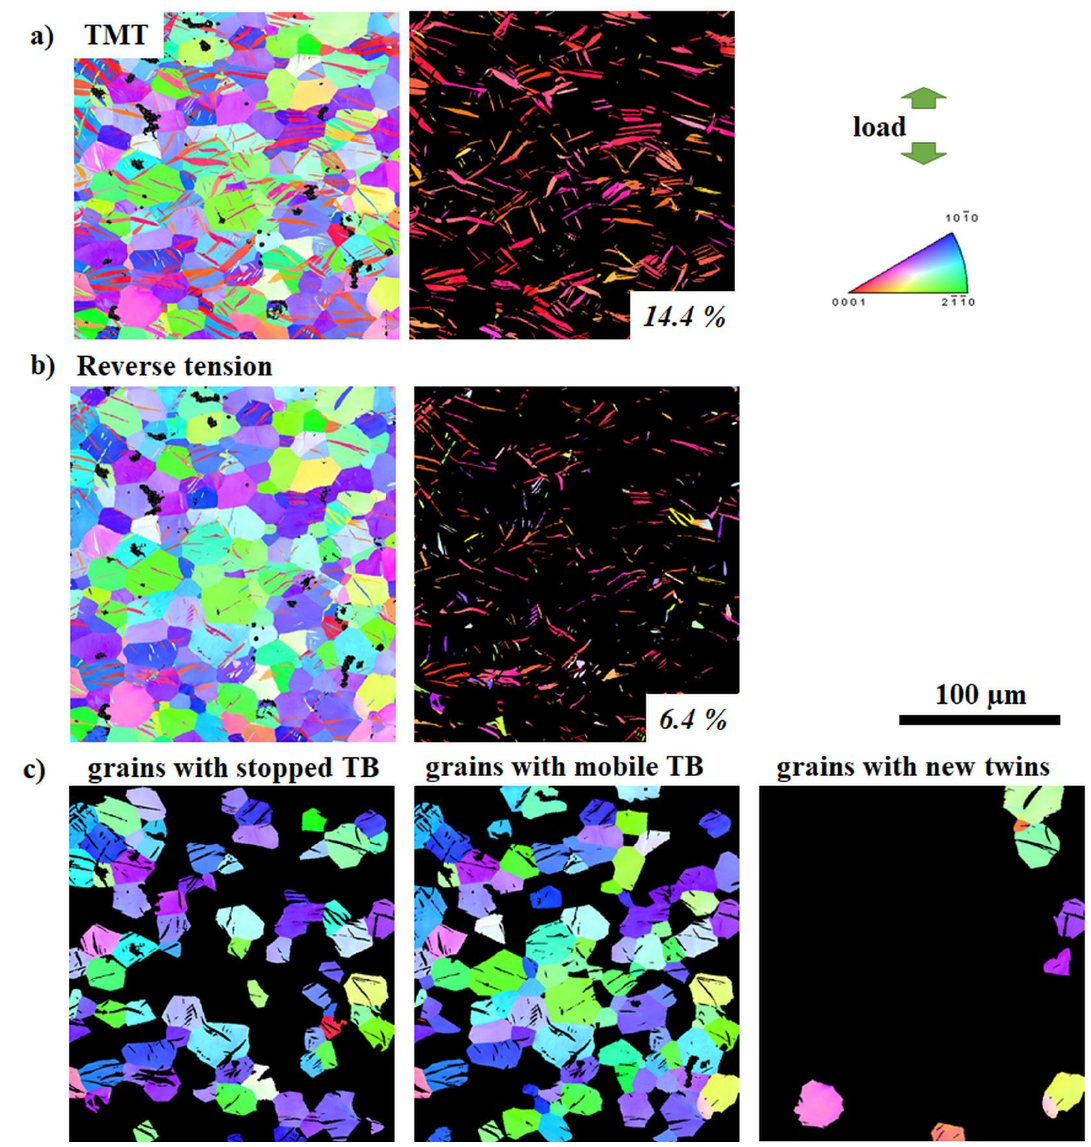
Figure 6. Orientation maps (entire microstructure and twins only) of the ZX10 alloy in the TMT state ( a ) and subsequent loading in tension up to 2% of strain ( b ). Orientation maps for grain grouping for reverse tensioned samples with respect to TB mobility ( c ). Color code for orientation maps represents orientation with respect to ED.